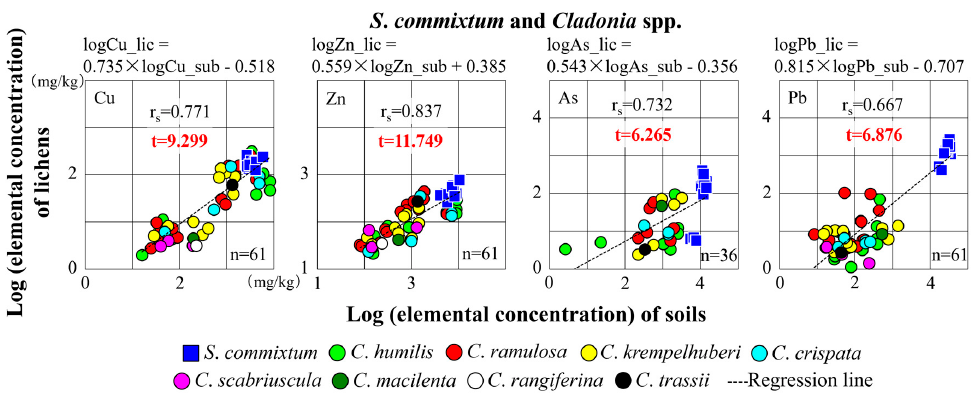
Figure 4. Scatterplots of Cu, Zn, As, and Pb concentrations in lichens and the corresponding substrata, with regression lines.